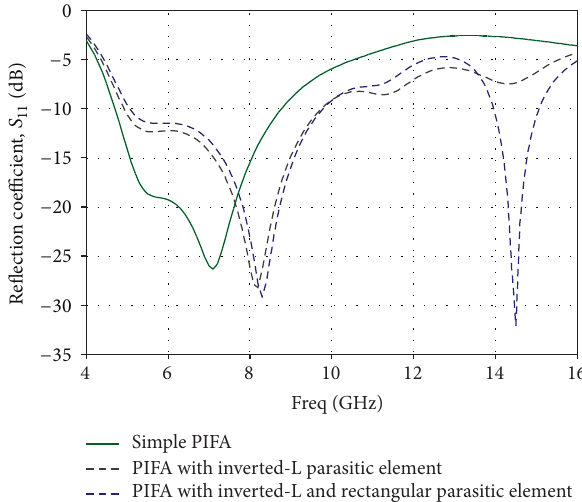
Figure 3: Magnitude of the simulated reflection coefficient of the PIFA with and without the inverted-L and rectangular shaped parasitic